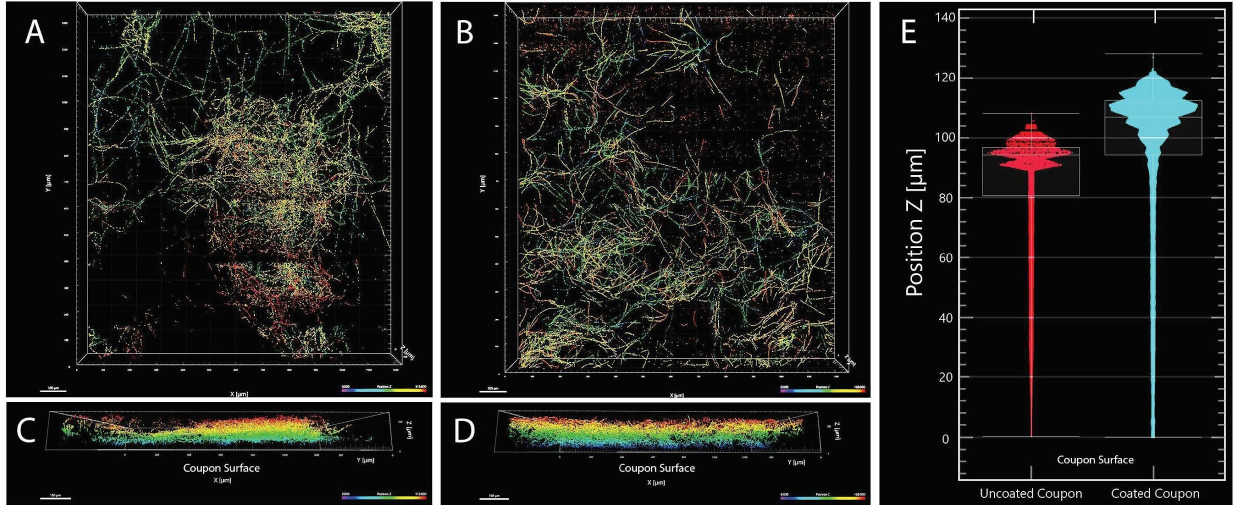
Figure 2. Confocal analysis of biofilm formation. Parengyodontium torokii isolate FJII-L10-SW-P1 was grown in PDB in the presence of untreated ( A , C ) and treated ( B , D ) Teflon coupons. Each scan was 1161 µm × 1336 µm and was taken at a representative location on the coupon surface. Composite confocal fungal space-filling structure is color-coded based on relative distance from the coupon surface with blue/violet being proximal to the surface and orange/red being distal. ( A , B ) are plan views of the region that was imaged (100 µm scale bars) while ( C , D ) are orthogonal views of the biofilm looking length-wise through the biomass (100 µm scale bars). The comparative biofilm dis- tribution as compared to distance from the coupon surface is presented in ( E ). The biofilm formed on the uncoated Teflon is smaller and the median height is closer to the surface while the biofilm from the coated Teflon coupon is larger and has a higher median height (94 µm and 107 µm, respec-